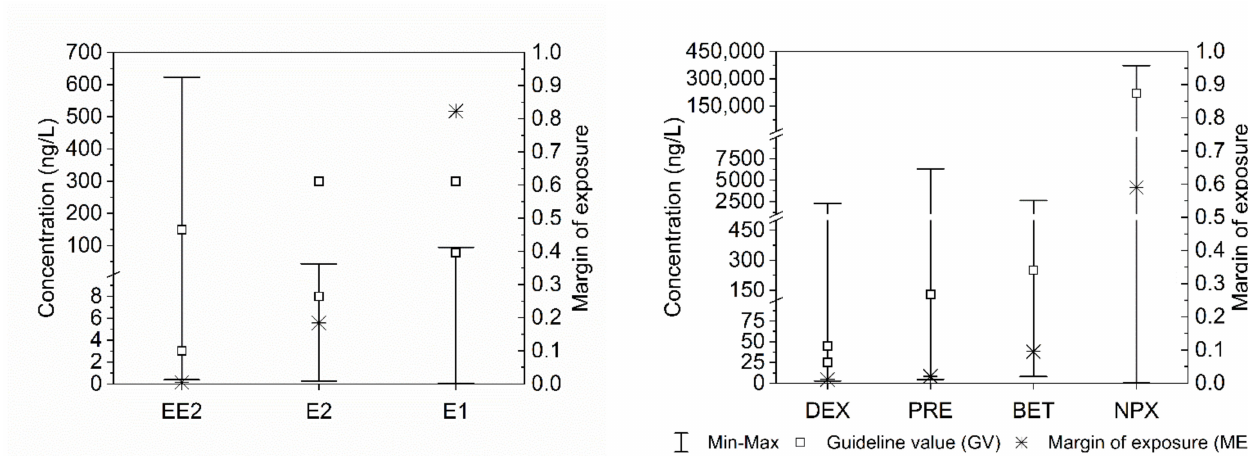
Figure 2. Concentration range, guideline values, and margin of exposure of pharmaceutical and endocrine disrupting compounds (P&EDC) quantified in Brazilian drinking water, which exhibited high risk. EE2 = 17-alpha-ethinylestradiol; E2 = 17-beta-estradiol; E1 = Estrone; DEX = Dexamethasone; PRE = Prednisone; BET = Betamethasone; NPX =